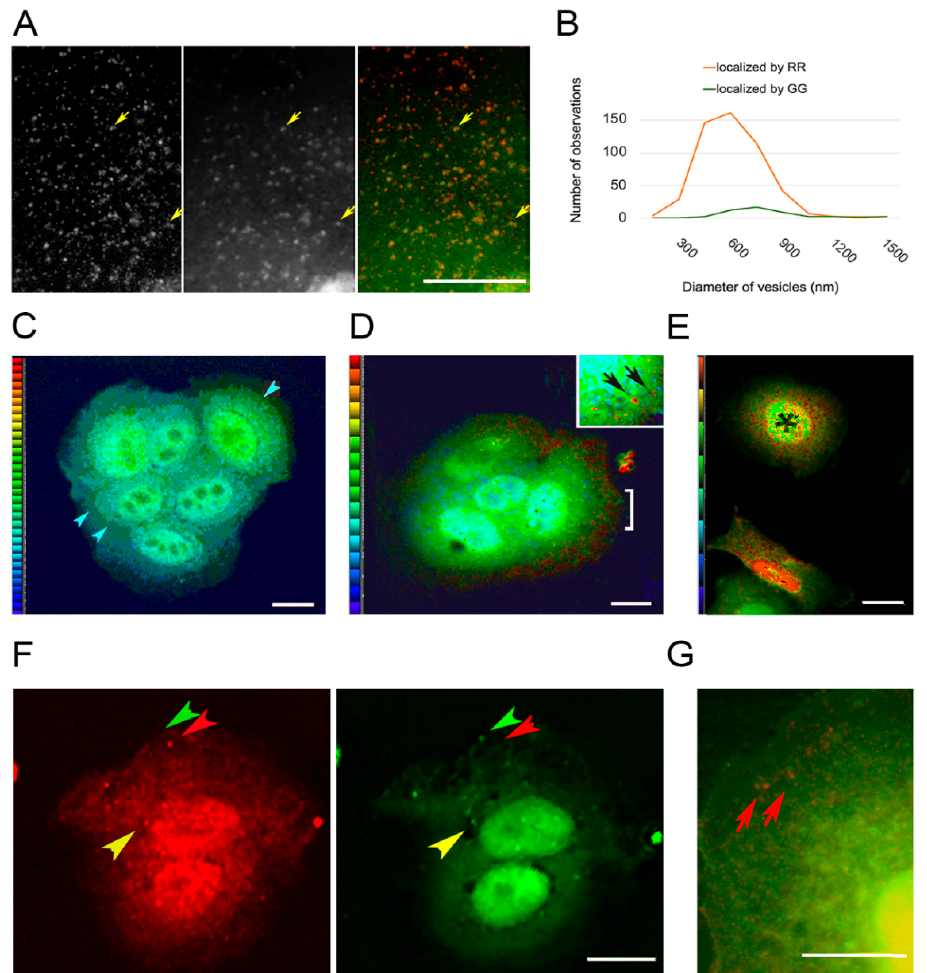
Figure 3. Two anti-PKC antibodies directed against epitopes identified by procedures GG and RR. ( A ) In untreated cells, the RR form (left panel, red) of PKC predominates on vesicles at the extreme cell edge (top), whereas the GG form is rarely present at the cell edge. Vesicles binding both forms are present in the cell interior (yellow arrowheads). ( B ) Size distribution of PKC-bearing vesicles, showing a peak at 400–600 nm for RR vesicles and a broad distribution centered around 750 nm for GG vesicles. ( C – E ) Heat maps with a color scale of blue to red indicating increasing GG / RR or RR / GG ratios. ( C ) GG / RR ratio shows a higher concentration in the lamella of untreated cells (blue arrowheads). ( D ) In a cell treated with PMA for 30 min, the RR / GG ratio is highest on vesicles near the cell edge (bracket). Inset: Highest ratio, indicated in red, shows that PKC is at the surface of hollow structures (arrows). ( E ) RR / GG ratio image of untreated cells showing a low ratio in one cell (asterisk) and a high ratio in the cell below. ( F ) Localization of the PKC RR (left, red) and GG (right, green) epitopes in cells after 30 min of PMA treatment. Some vesicles are coated with only the RR form (red arrowheads). Some have only the GG form (green arrowheads), and some have both forms (yellow arrowheads). ( G ) In a cell exposed to PMA for 10 h, PKC localized by the RR antibody (red) is in large vesicles near the cell edge (red arrows) but when localized by the GG antibody (green), di ff use in the cytoplasm. Bars = 10 µ